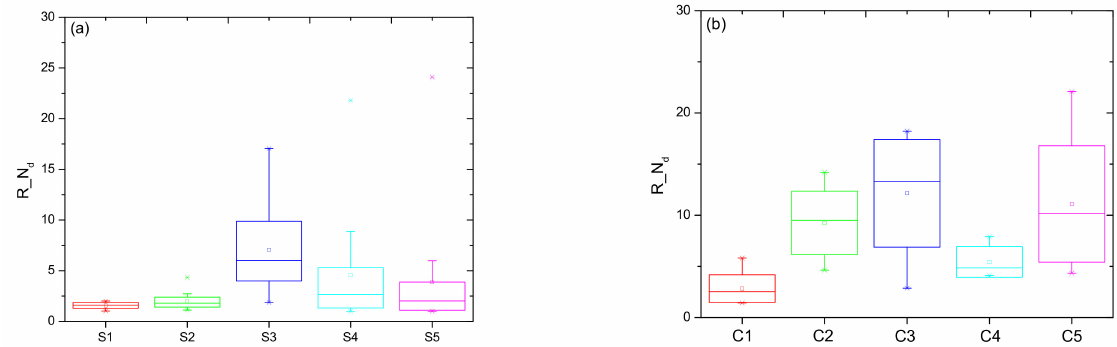
Figure 6. Statistics of R _ N d in the selected cloud area: ( a ) stratiform; ( b )